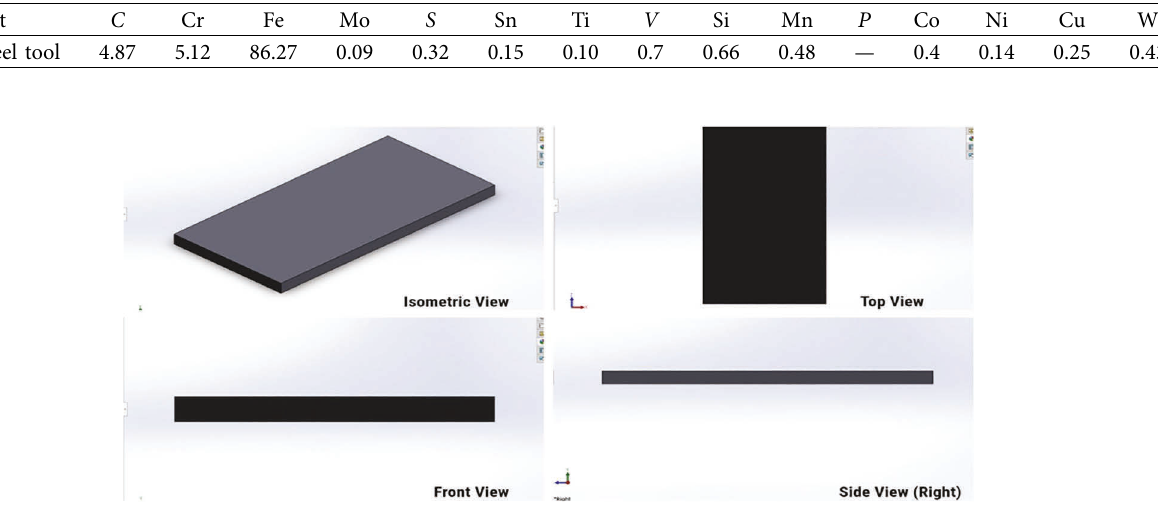
Figure 2: 3D model of base plate in different